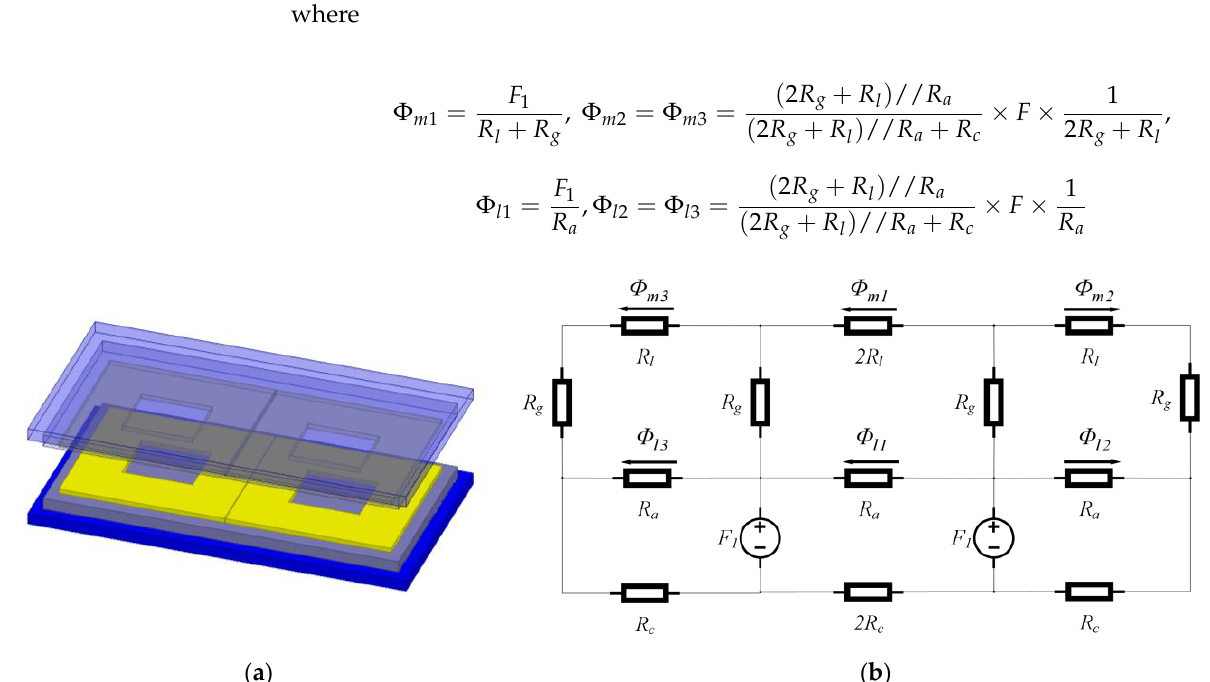
Figure 5. Double-D type coupler: ( a ) Sketch of the coupler; ( b ) Magnetic circuit.